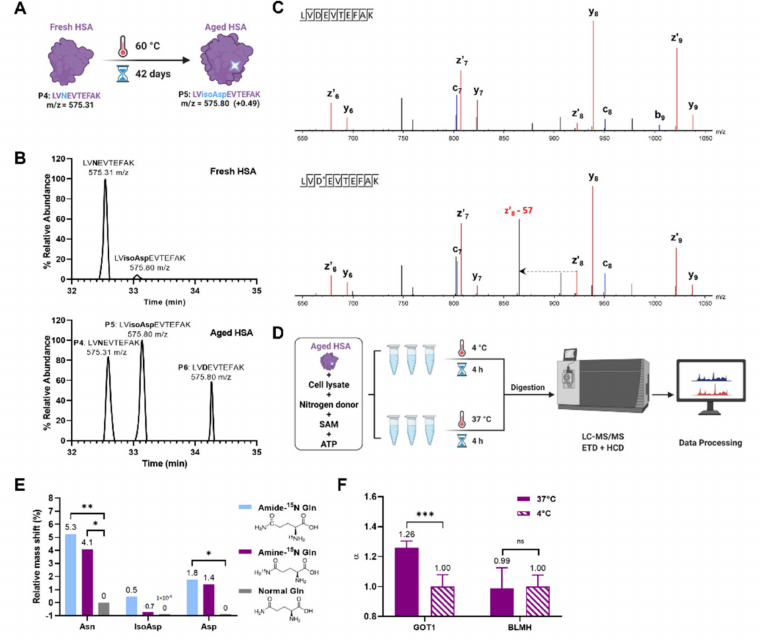
Figure 3. Discovery of PSIAL activity on aged HSA. ( A ) Artificial deamidation of fresh HSA to aged HSA via incubating at 60 ◦ C for 42 days. ( B ) The chromatogram of fresh ( up ) and aged ( down ) HSA (D* = isoAsp). ( C ) ETD MS/MS spectrum confirms the isoAsp presence by the z 8 (cid:48) -57 ion ( up ), and its absence in the corresponding peptide with Asp (down). ( D ) The scheme of testing PSIAL activity in cell lysate using aged HSA and cofactors. ( E ) The mass shift in the Asn form of an HSA reporter peptide after adding Amine- 15 N L -Gln, Amide- 15 N L -Gln, and isotopically normal L -Gln. ( F ) Validation of PSIAL activity in GOT1 protein with BLMH as a negative control. * p < 0.05, ** p < 0.01, *** p <